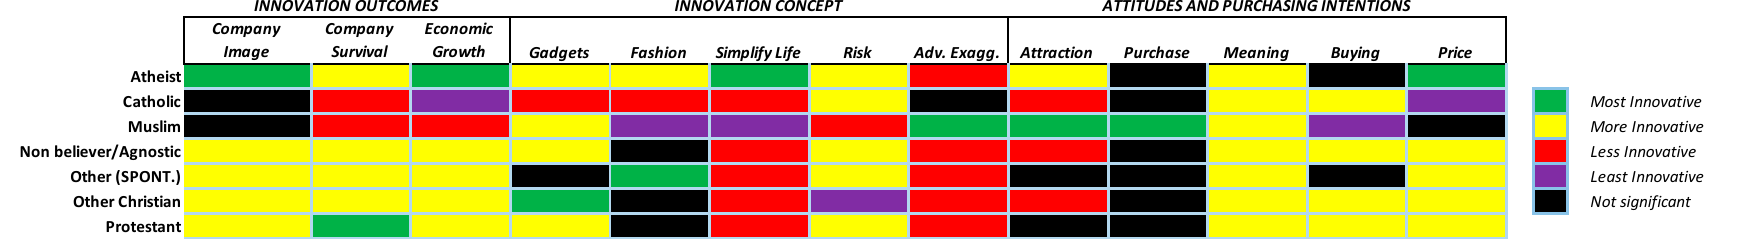
Figure 4. Marginal effects results on all innovation variables under study.